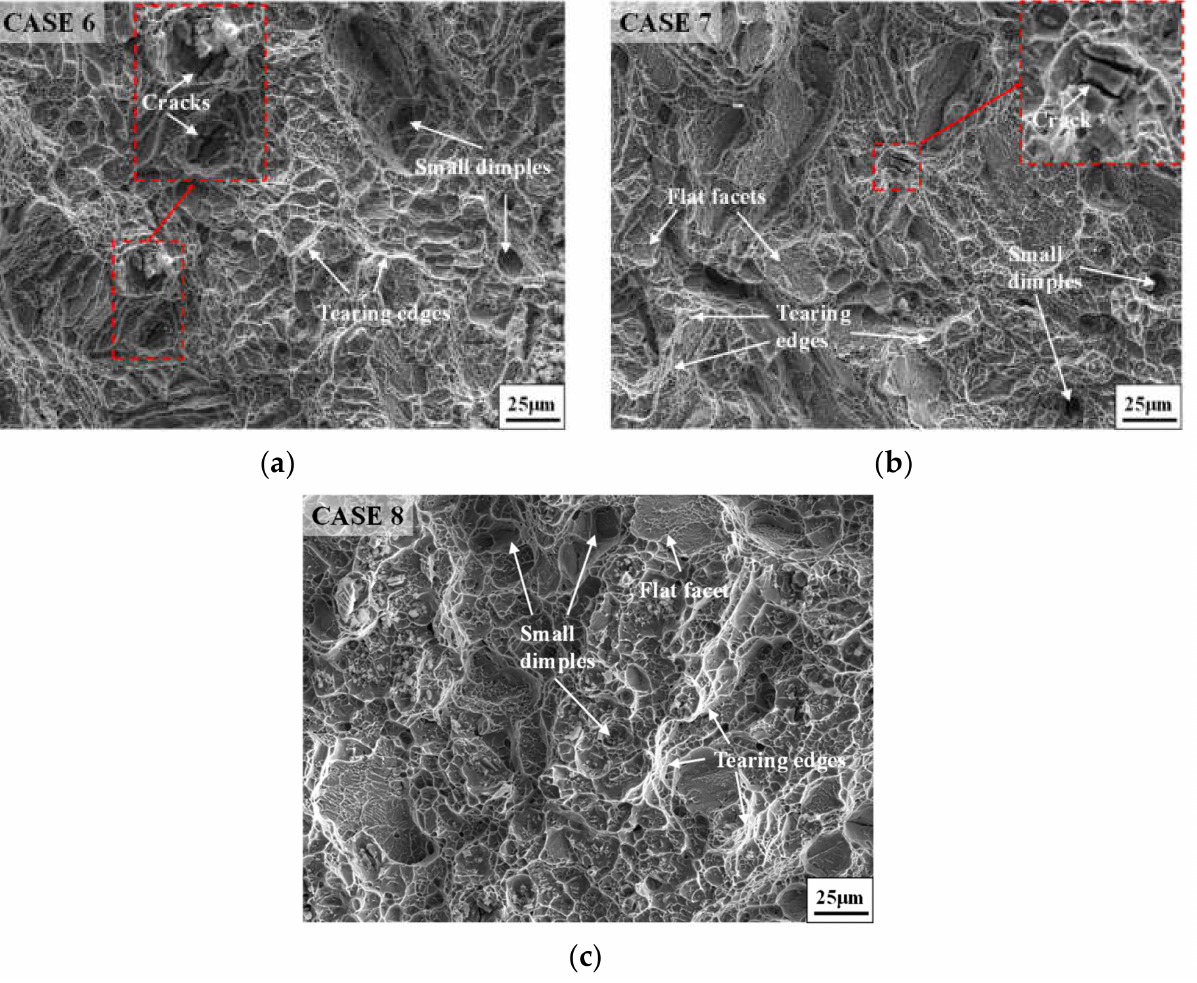
Figure 6. Fracture morphologies of annealed samples with different SSA times: ( a ) 10 min; ( b ) 30 min; ( c ) 90